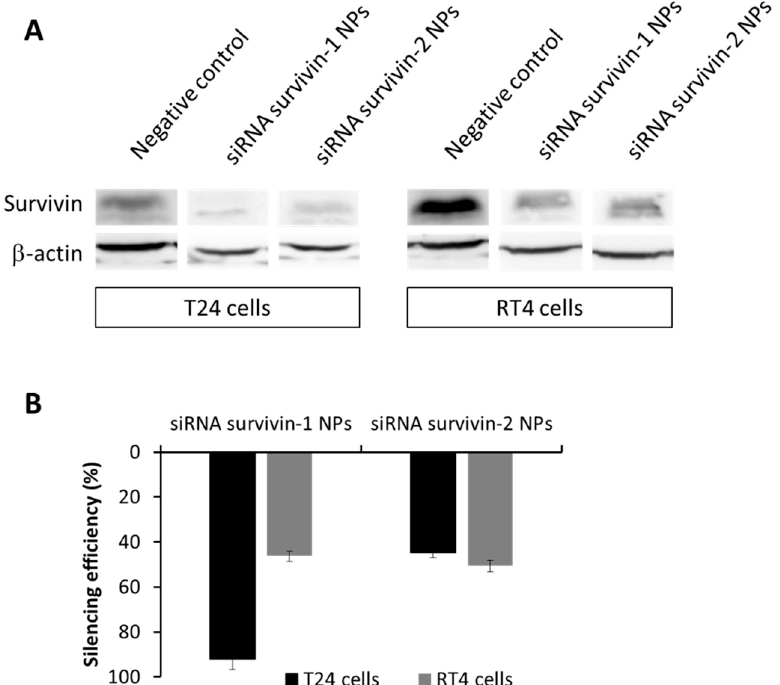
Figure 8. Survivin expression modulation by nanoparticles treatment. ( A )—Western blot bands of T24 and RT4 survivin expression, after 3 days treatment; and ( B )—Quantification of the silencing efficiency (%).